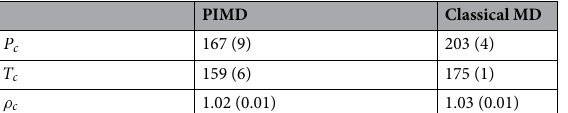
Table 1. Estimated pressure P c , temperature T c , and density ρ c of the LLCP of q-TIP4P/F H 2 O. Values of P c , T c , and ρ c are obtained by using the TSEOS in combination with data from classical MD and PIMD simulations at 180 ≤ T ≤ 325 K. Numbers in parenthesis are standard